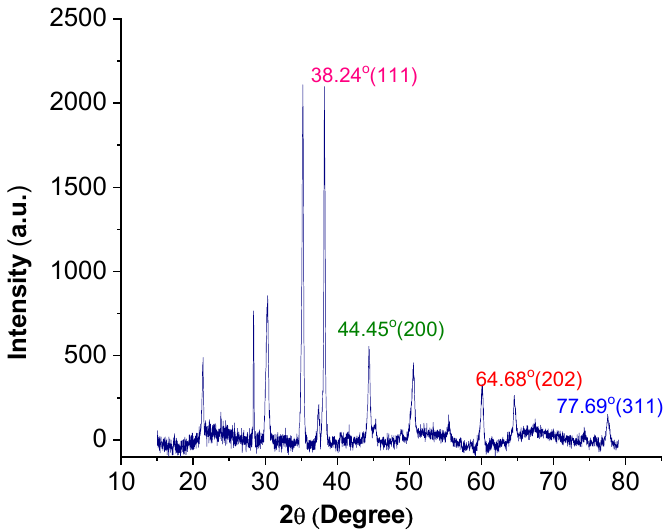
Figure 4. XRD spectrum of AuNPs.